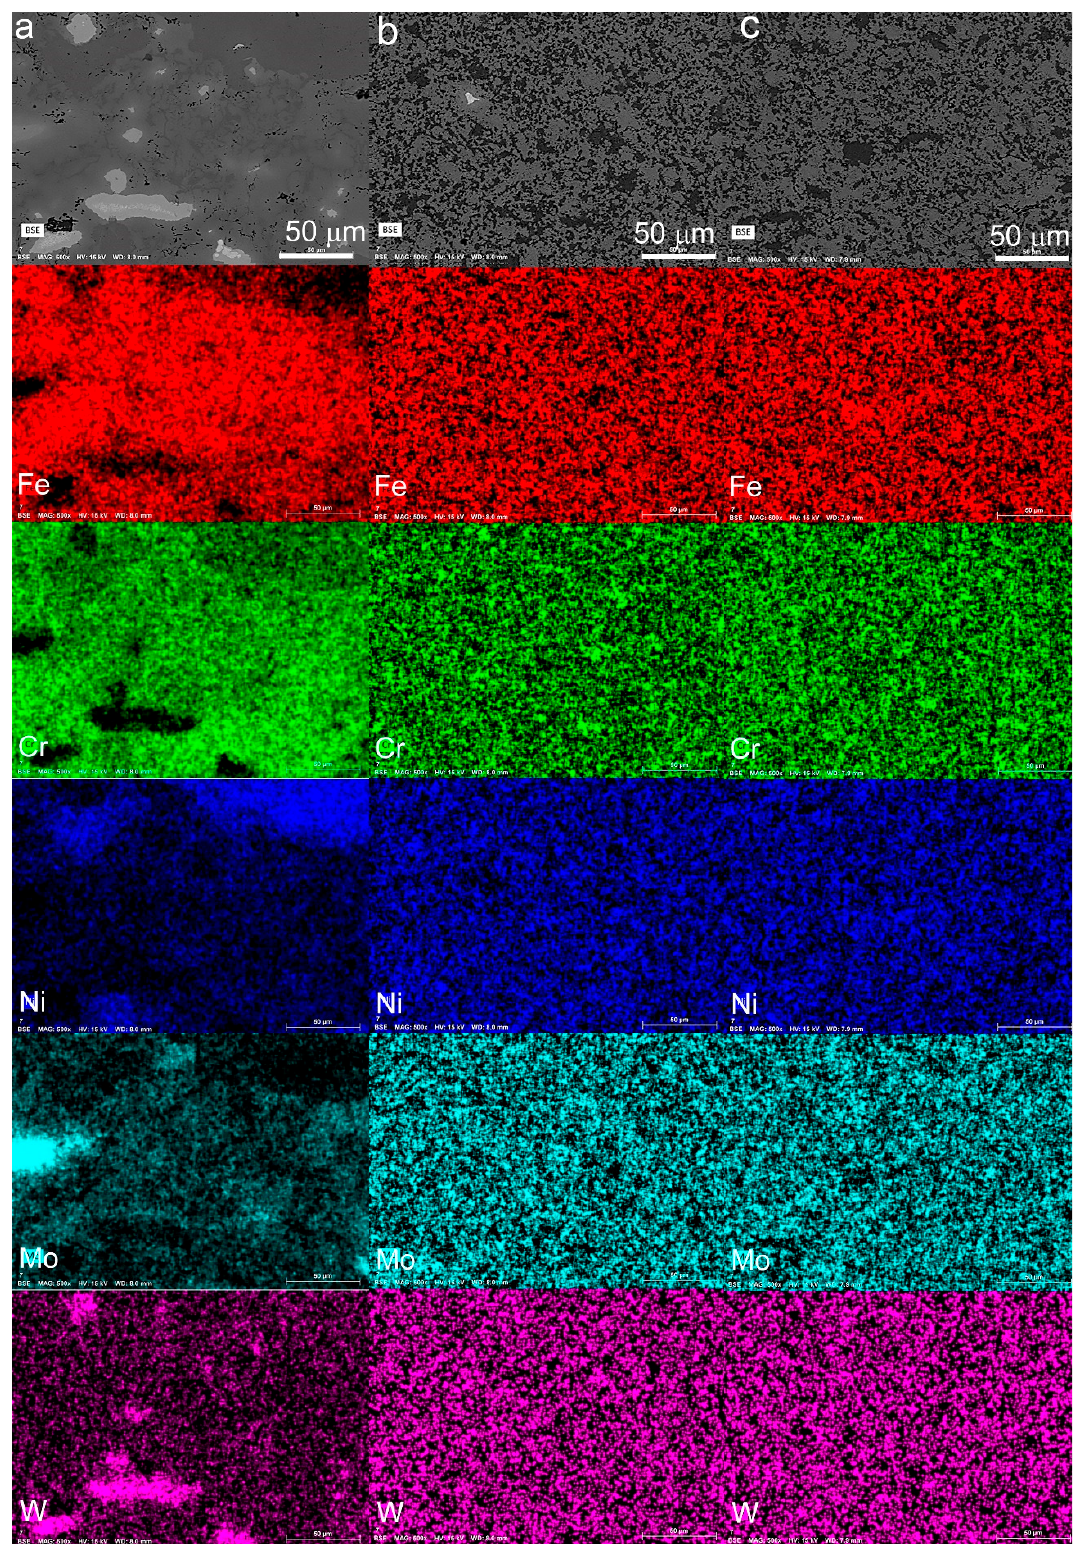
Figure 9. SEM image and EDX maps of Fe, Cr, Ni, Mo, and W for 30Fe30Cr20Ni10Mo10W specimens produced by pressure-assisted sintering: ( a )—from 5 h of mixing; ( b )—from milling for 2.5 h; ( c )—from milling for 5 h.